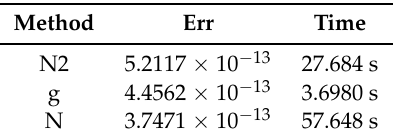
Table 6. Comparison between different approach to the outer iteration. The table show the real error and the time.